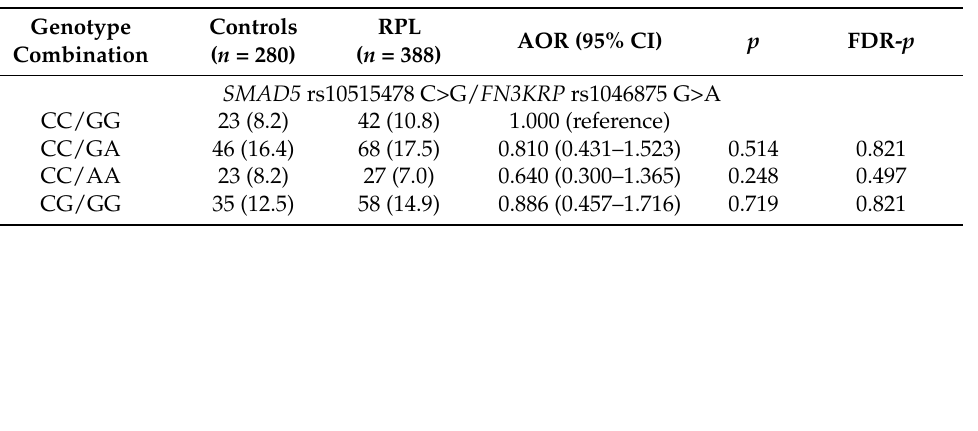
Table 4. Combination analysis of gene polymorphisms between control and RPL